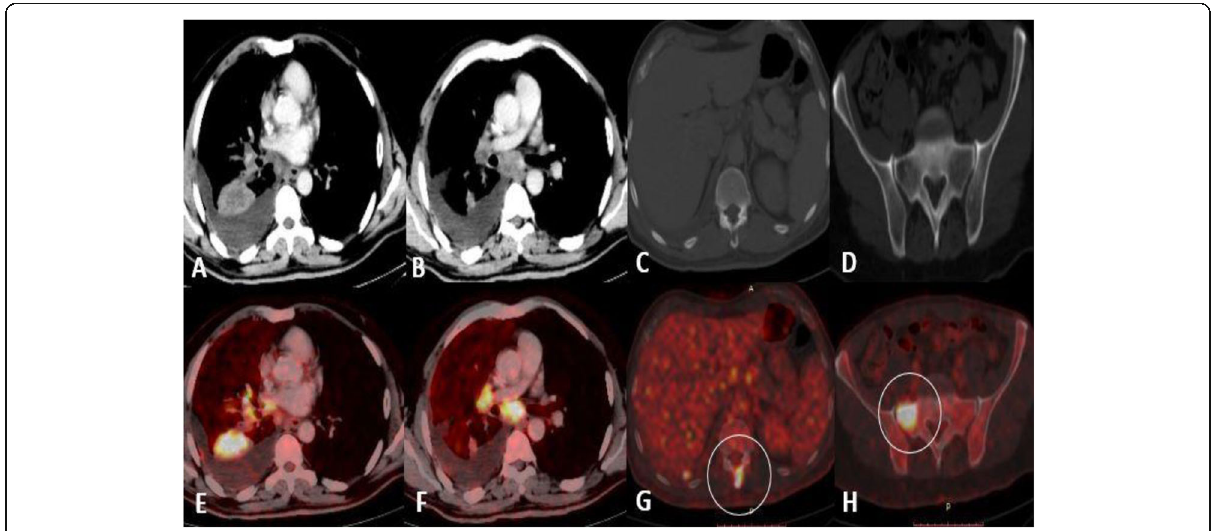
Fig. 7 a – h A male patient 68 years old presented with dyspnea and repeated chest infection with attacks of hemoptysis and proved histopathologically to have NSCLC. CT study reveals a malignant mass lesion involving the right lower lobe with multiple malignant mediastinal and hilar lymphadenopathies. Bone examination via CT was negative yet with PET/CT multiple scattered FDG uptake marrow lesions detected involving the spinous process of L1 and right aspect of the sacrum considered metastatic bony lesions (M1c). The surgical staging of the patients by PET/CT changed from IIIB to